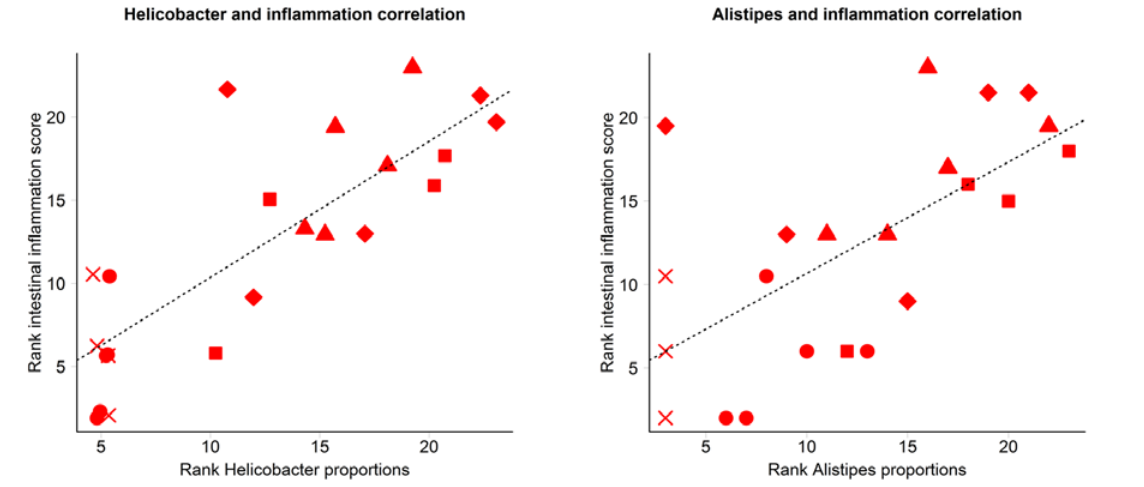
Figure 6. Correlation between rank of intestinal inflammation scores reported previously [20,21] and rank of proportions of selected bacterial taxa identified from pyrotag sequencing across all inoculation treatments in C57 and Il10 -/- mice. Dotted line indicates linear regression. Blue points indicate C57 mice and red points indicate Il10 -/- mice. Shapes of the points indicate treatment groups: SPF (×), C (circle), CIF (square), EF (diamond), and EF.CIF